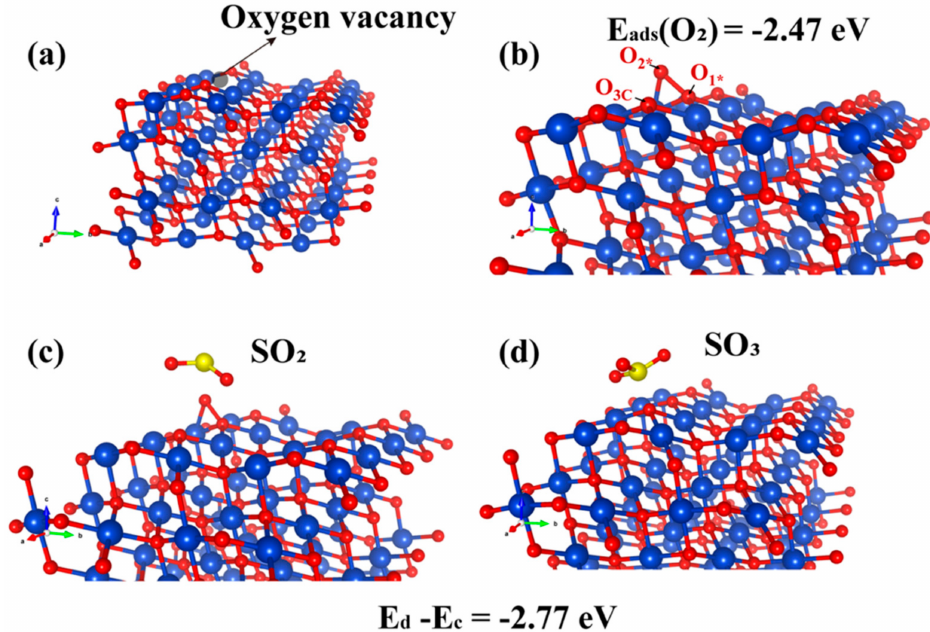
Figure 6. Adsorption configuration of SO 2 molecules on the oxygen-vacancy CuO (111) (Cu, O and S atoms are depicted in blue, red and yellow, respectively). ( a )The oxygen vacancy on CuO (111). ( b ) O 2 adsorption on CuO (111) surface. ( c ) Optimized configurations of SO 2 adsorption on O 2 − adsorbed CuO (111). ( d ) SO 2 adsorption on CuO